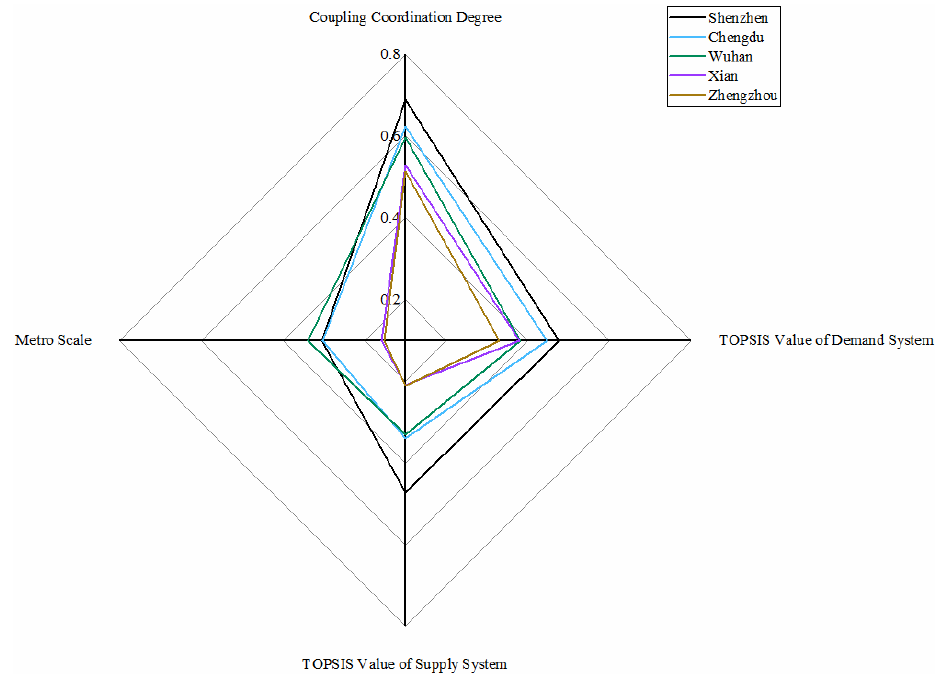
Figure 6. Metros in barely balanced with lagging supply conditions.